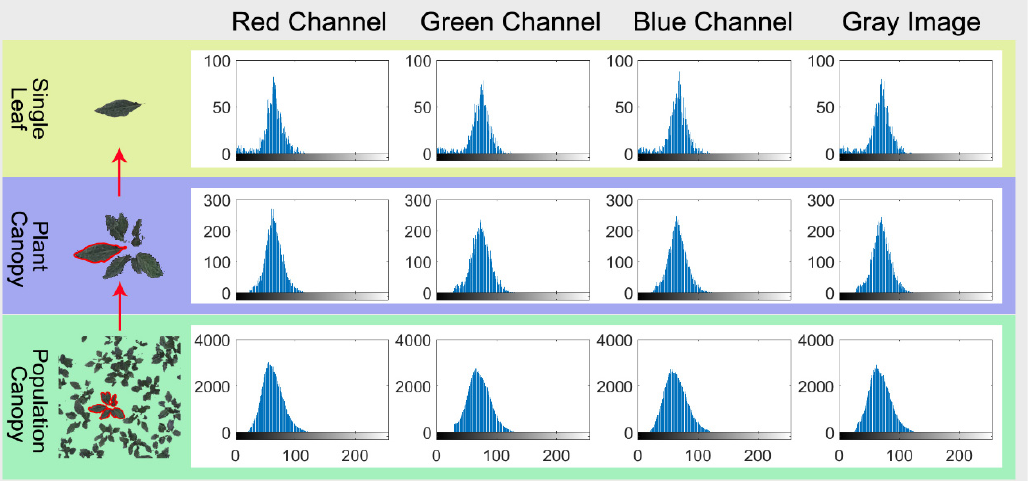
Figure 3. RGB model color gradation distribution of single leaf, plant canopy, and population canopy images of Begonia Fimbristipula Hance (BFH). The cumulative frequency histogram of red, green, and blue channels, as well as gray-level images, were drawn using the imhist function of MATLAB. The X-axis is the color gradation value, and the Y-axis is the cumulative frequency.